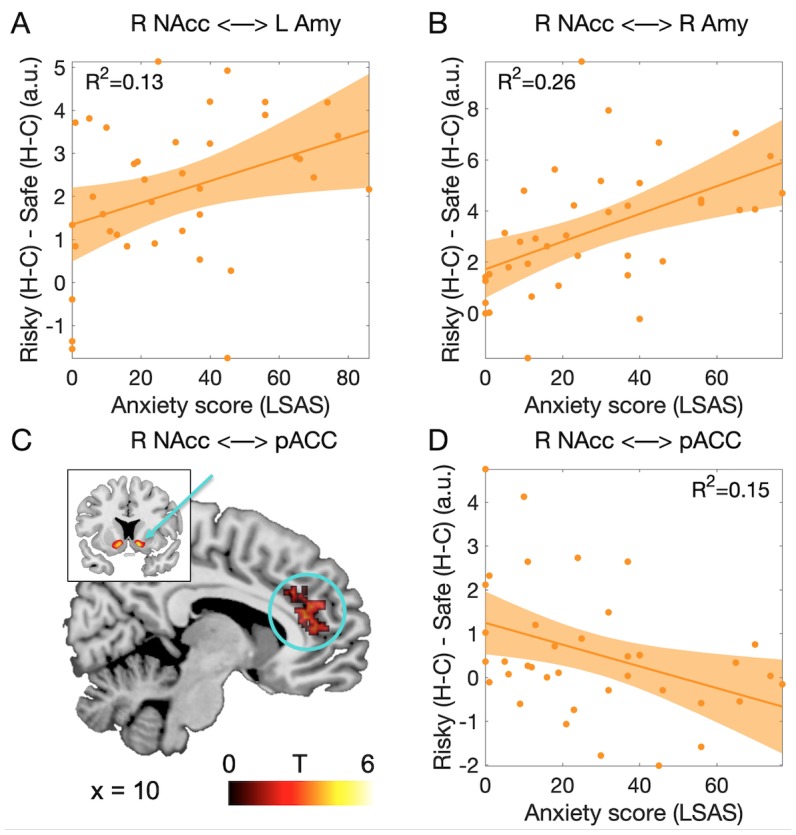
Functional connectivity associated with the decision to engage in the social situation.(A) Connectivity between left NAcc and right amygdala increased with the level of social anxiety. (B) Connectivity between right NAcc and right amygdala showed the same effect. (C) Cluster of voxels in the perigenual anterior cingulate cortex (pACC, BA24a/b; circle) showing functional connectivity modulation with right nucleus accumbens (arrow) as a function of the partner and social anxiety. Threshold was p<0.05 FWE-corrected for multiple comparisons across the whole brain at the cluster level (based on p<0.001 uncorrected threshold, minimum cluster size = 100 voxels). (D) Connectivity between right NAcc and pACC decreased proportionally to the level of social anxiety. Abbreviations as in Figures 3 and 4; pACC: perigenual anterior cingulate.